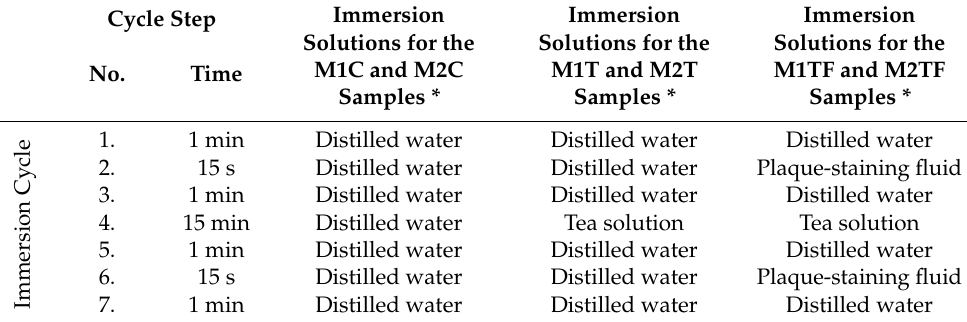
Table 3. Experimental setup: immersion cycles used. Cycle